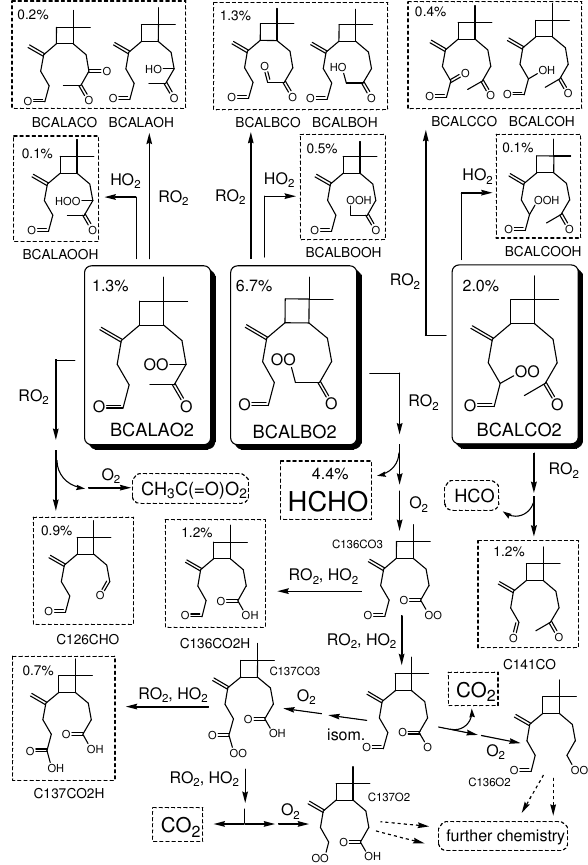
Figure 3. Partial schematic of the product distribution from the further chemistry of 3 Fig. 3. Partial schematic of the product distribution from the fur- ther chemistry of BCALAO2, BCALBO2 and BCALCO2, formed BCALAO2, BCALBO2 and BCALCO2, formed from E(cid:16) caryophyllene ozonolysis in MCM 4 from β -caryophyllene ozonolysis in MCM v3.2, as shown in Fig. 1. v3.2, as shown in Fig. 1. The displayed (molar) product yields correspond to ozonolysis at 5 The displayed (molar) product yields correspond to ozonolysis at 298 K in 760 Torr air at 50% relative humidity; with cyclohexane present to scavenge all OH 6 298K in 760Torr air at 50% relative humidity; with cyclohexane present to scavenge all OH radicals (the displayed products account radicals (the displayed products account for | 89% of the total product carbon from the 7 for ≈ 89% of the total product carbon from the onward reaction of onward reaction of these peroxy radicals). 8 these peroxy